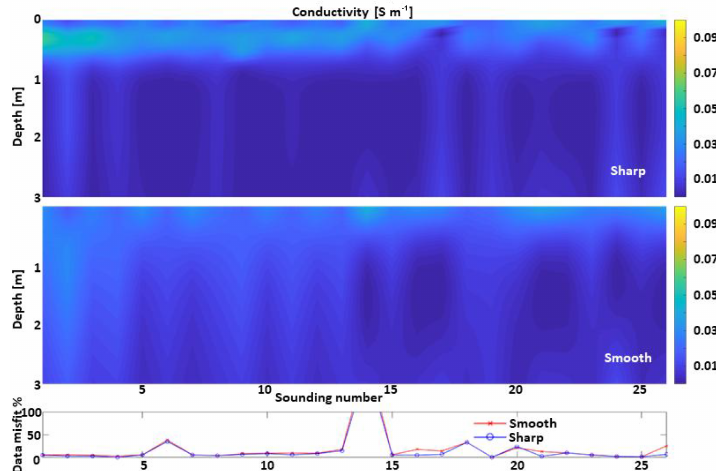
Figure 4. Examples of sharp and smooth inversions applied to the dataset 50-6dS. The results are shown together with their corresponding data